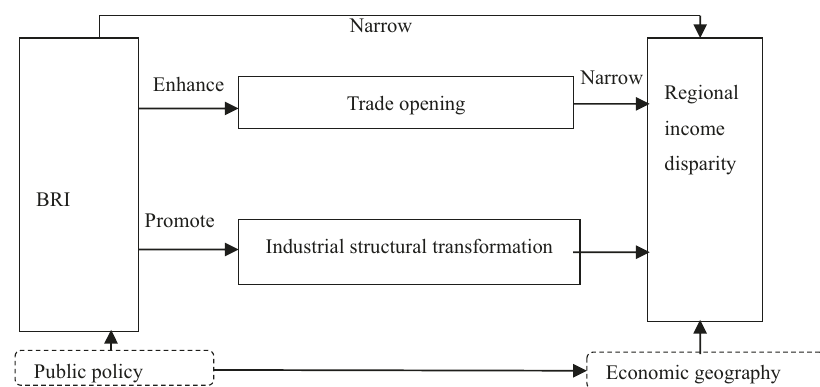
Fig. 7 Theoretical framework of the impact of BRI on income disparity: effect and transmission